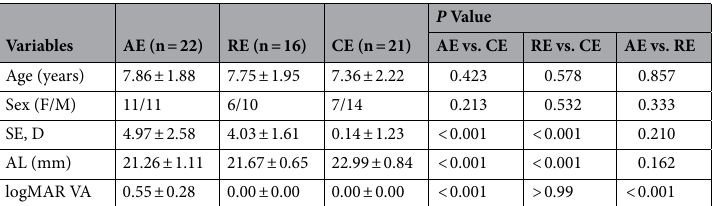
BCVA prior to refractive correction and Age at diagnosis (years) occlusion